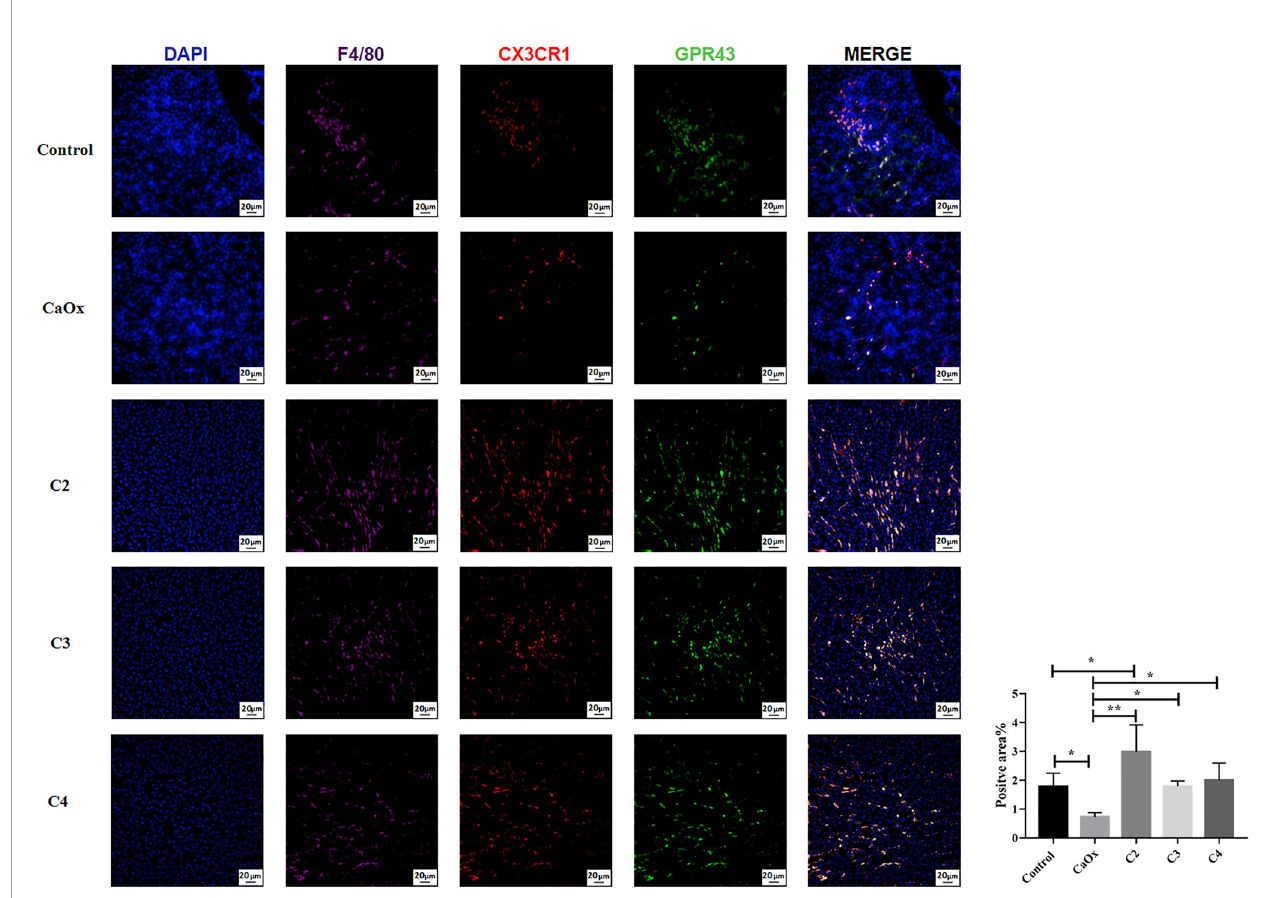
FIGURE 10 | Representative images of immuno fl uorescence staining of macrophages in kidney of controls, CaOx mice and CaOx mice administration of SCFAs. 647 (F4/80, Violet), PE (CX3CR1, red) and FITC (GPR43, green) fl uorescence images and merged images with DAPI staining (blue) of the same sections are also shown. Statistically signi fifi cant was shown as *p < 0.05, **p <